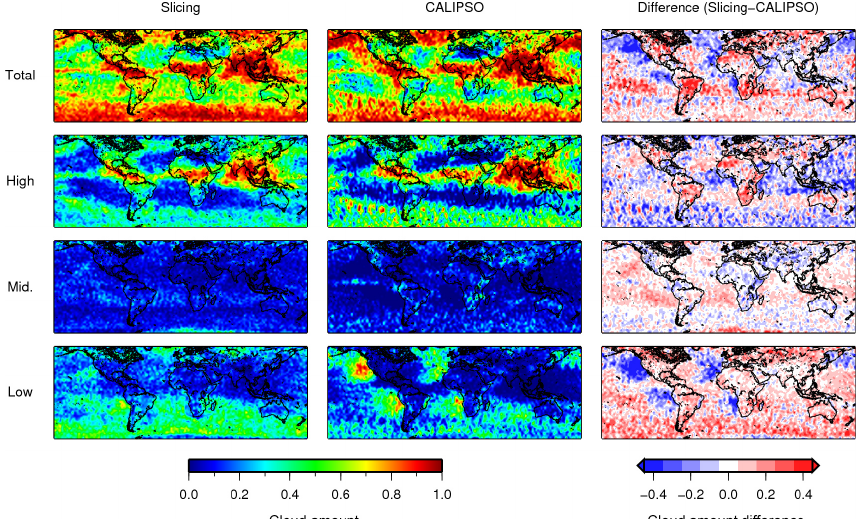
Figure 10. Same as in Fig. 9 but for